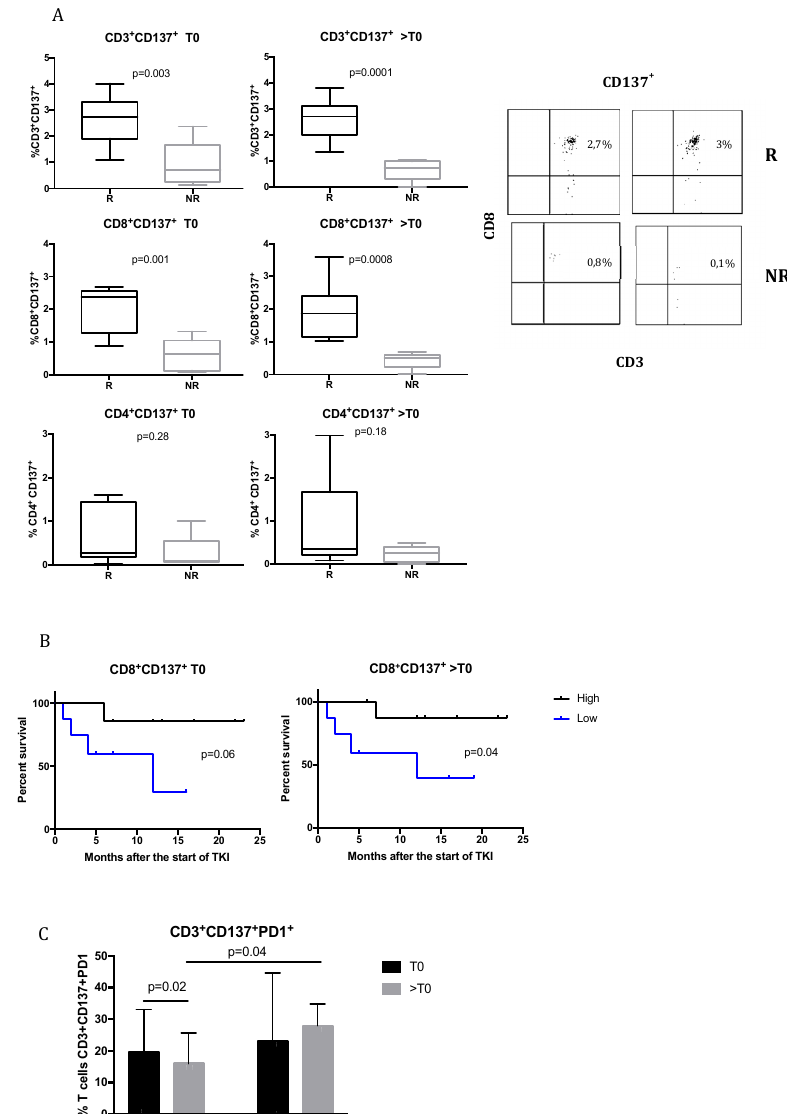
Figure 1. ( A ) Immune cell subpopulations were evaluated using flow cytometry and analyzed by FACSDiva Software. To analyze the CD137 + T cells, lymphocytes were first gated on FSC-A and SSC-A, and then the CD3 + T-cell subpopulation was selected from the lymphocytes. CD3 + CD137 + T cells were then selected and analyzed for CD4 and CD8. The results are shown as percentages of CD3 + CD137 + , CD8 + CD137 + and CD4 + CD137 + T cells in responsive (R) and non-responsive (NR) patients at baseline (T0) and during tyrosine kinase inhibitor (TKI) treatment ( > T0). The dot plot analysis of the CD3 + CD8 + CD137 + T lymphocytes is shown in the right of panel A. The results are representative of one R patient and one NR metastatic renal carcinoma (mRCC) patient. ( B ) Survival analysis at baseline and during treatment of mRCC patients treated with TKI. At T0, survival analysis of the mRCC patients was conducted, comparing those with greater than 1.4% of CD8 + CD137 + T cells to those with less or equal to 1.4%. During TKI therapy ( > T0), a survival curve was calculated using the value of 1.3% to distinguish high and low percentages of CD8 + CD137 + T cells. Log-rank tests were used to compare the survival between two groups. ( C ) Expression of PD1 molecules on the CD3 + CD137 + T lymphocytes. The results are reported as percentages of PD1 normalized on CD3 + CD137 + T cells in R and NR patients a T0 and during TKI therapy ( > T0). Statistical significance was determined by a Student’s unpaired t -test. A p -value of < 0.05 was considered statistically